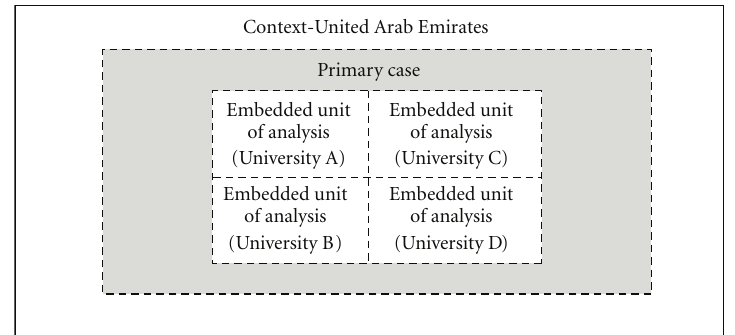
Figure 2: Single-embedded case design in this study (adapted from [13, page